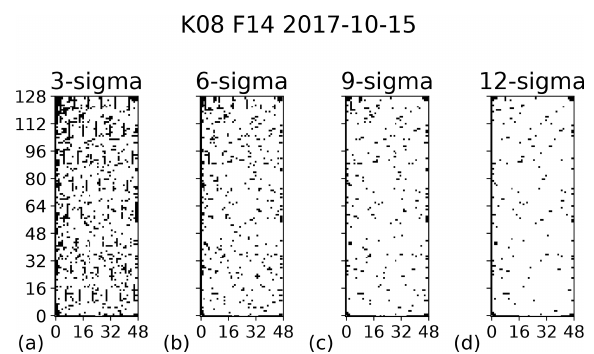
Figure 11. Different bad-pixel masks for the 14th flight of the WISE campaign. Bad pixels are colored black. Panel (a) : for a 3 σ thresh- old (19.0% filtered). Panel (b) : for a 6 σ threshold (10.4% filtered). Panel (c) : for a 9 σ threshold (6.9% filtered). Panel (d) : for a 12 σ threshold (5.2% filtered).